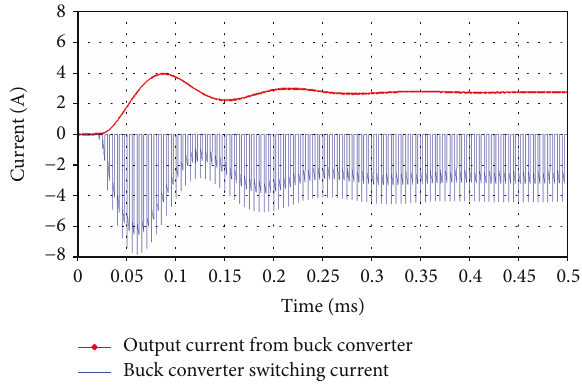
Figure 11: Input and output current waveforms for 70V input.